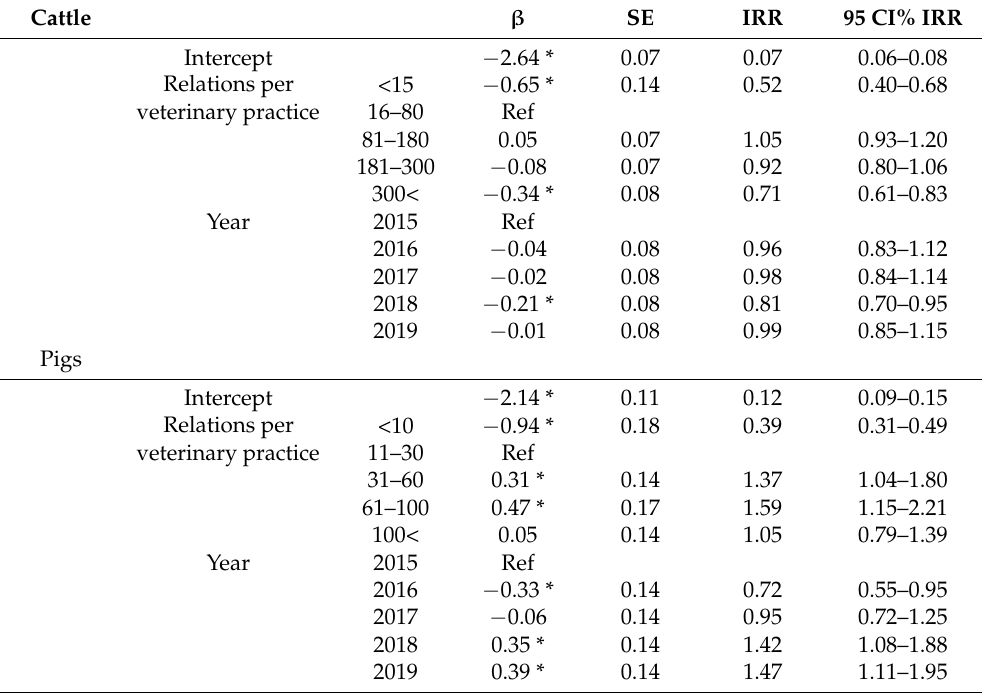
Table 8. Association between the number of relations of a veterinary practice to the number of contact to the veterinary helpdesk from 2015 to 2019 in the Netherlands. Cattle